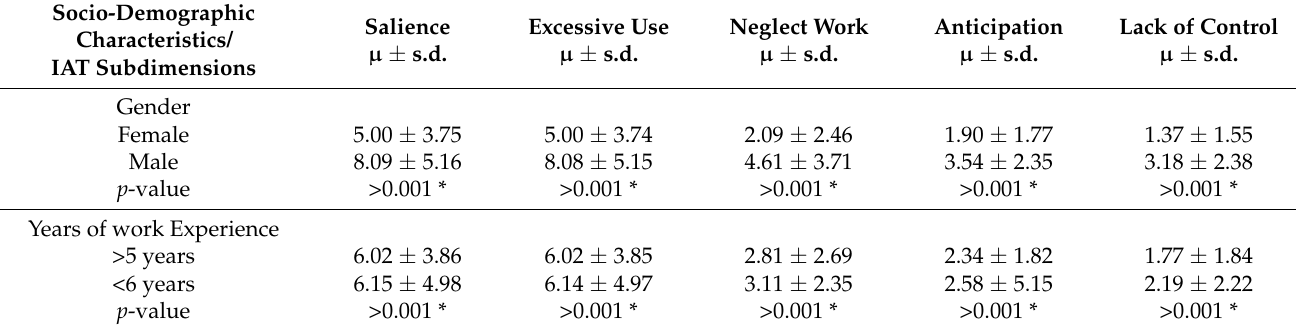
Table 2. Exploring IAT subdimensions according to socio-demographic